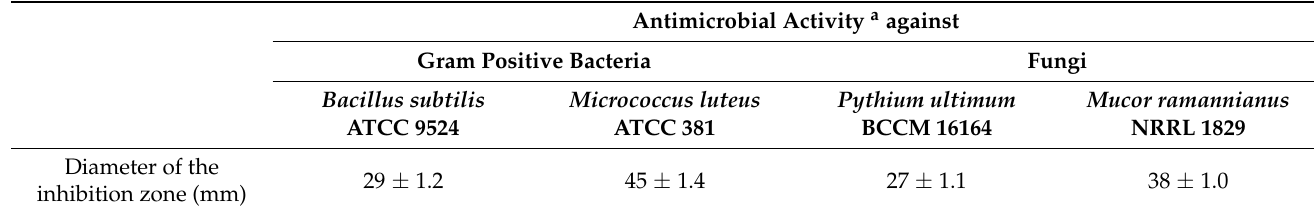
Table 1. Antimicrobial activity of the D 2 compound.